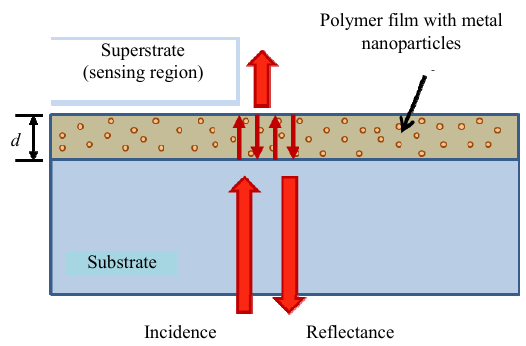
Fig. 1 Proposed humidity sensor: nanocomposite with thickness d is coated on a glass